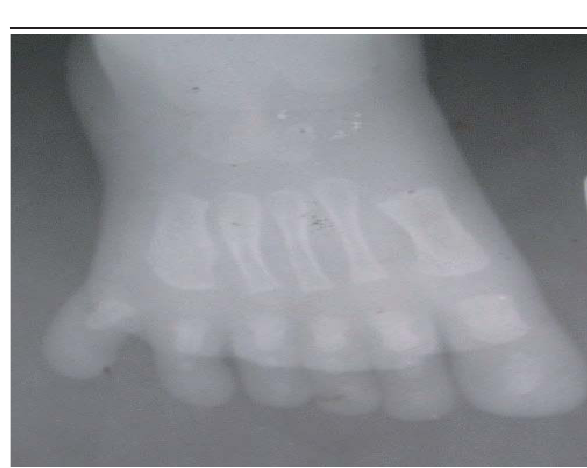
Figure 2. Radiograph of right foot showing postaxial polydactyly with broad 5 th